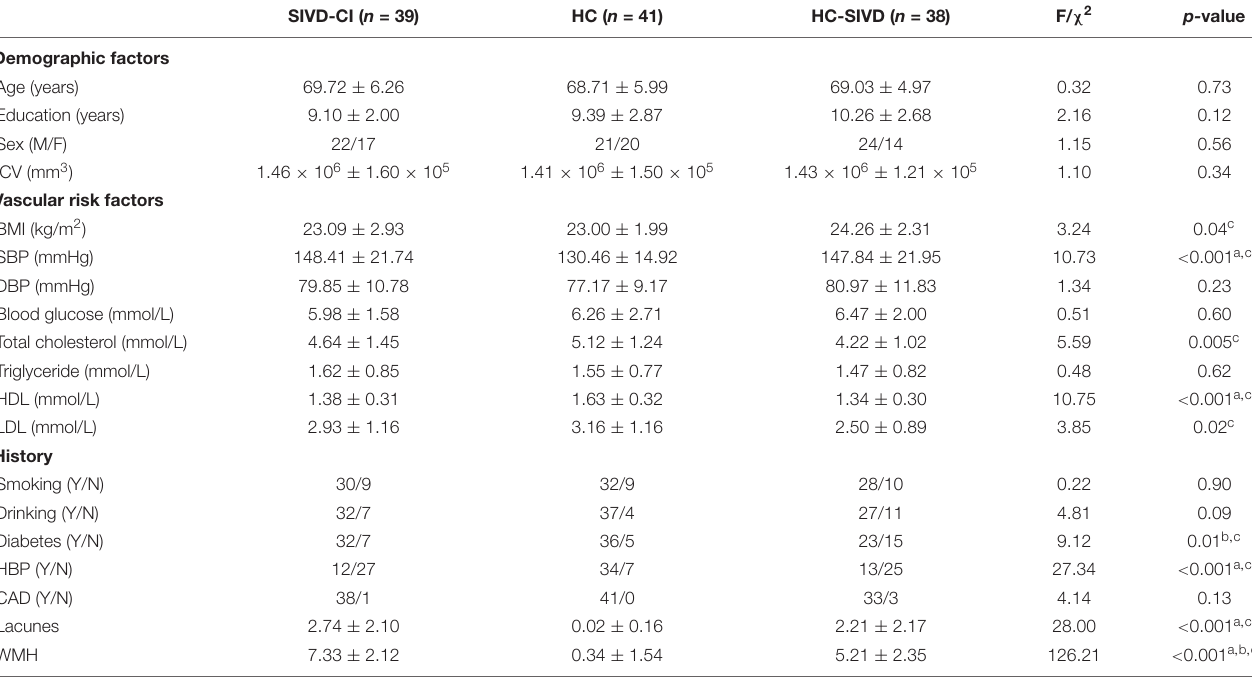
TABLE 1 | Comparisons of demographic and clinical data of the SIVD-CI, HC and HC-SIVD